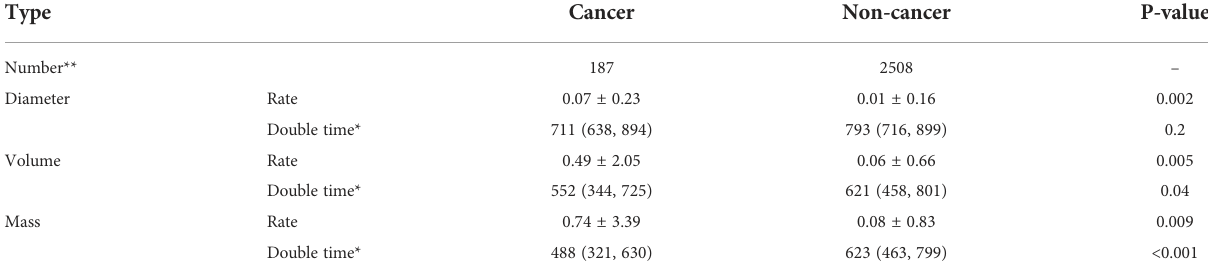
TABLE 1 Different rates of change (between the latest two consecutive examine) in the NLST